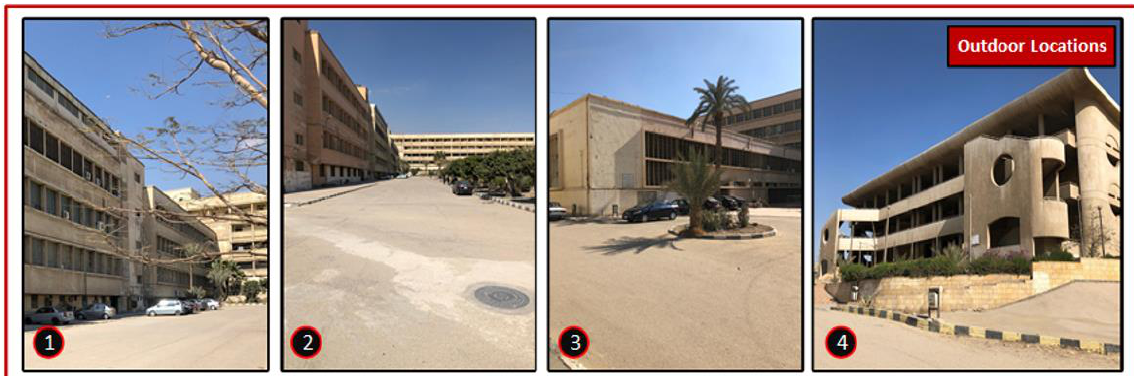
Figure 11. Images of outdoor/buildings